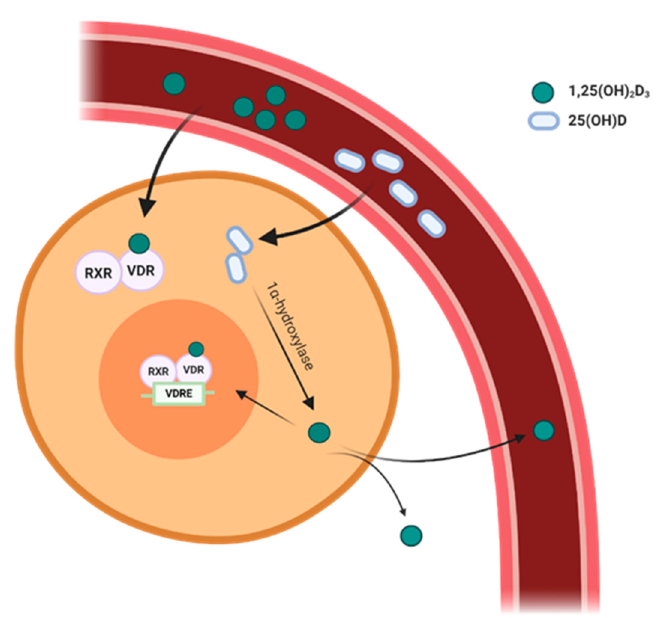
Figure 1. Biological effects of vitamin D signaling in vitamin D receptor (VDR)-expressing target cells are determined by the sum of circulating 1,25(OH) 2 D concentrations in addition to locally produced 1,25(OH) 2 D. The 1,25(OH) 2 D 3 –VDR complex dimerizes with the retinoid X receptor (RXR) and translocates to the nucleus where it binds to vitamin D response elements (VDRE) found in the promoter region of target genes. 25(OH)D originating from the blood stream can be locally converted into 1,25(OH) 2 D in cells expressing 1 α -hydroxylase.